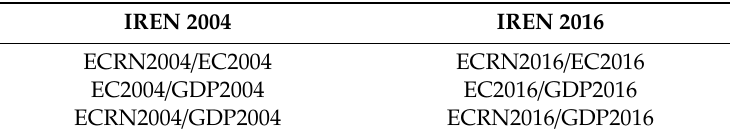
Table 2. Indicators of new renewable energy.